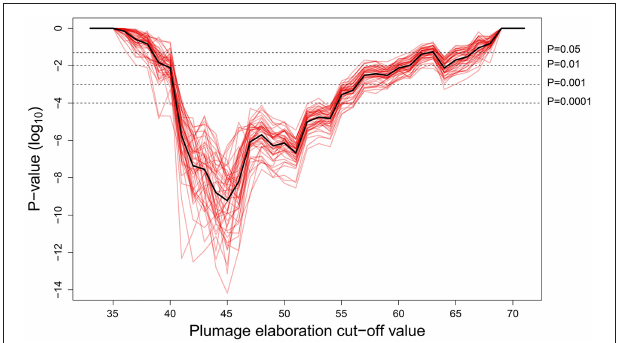
FIGURE 3 | Pagel correlation test P -values (Pagel, 1994) at all possible plumage elaboration cutoff values, for each of 50 phylogenetic trees from http://birdtree.org (Jetz et al., 2012). The black line indicates the mean of the 50 runs (red lines). Evidence of correlated evolution is strong ( < 0.0001) for all plumage cut-off values between 41 and 54.